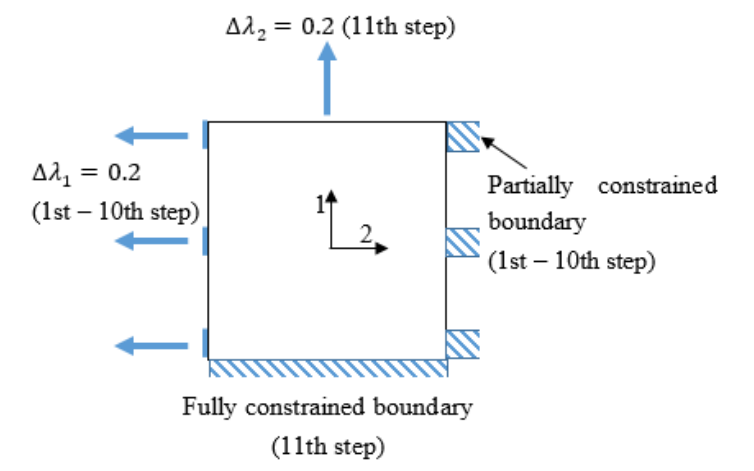
Figure 11. Boundary condition configurations for finite element simulations over 11 steps.